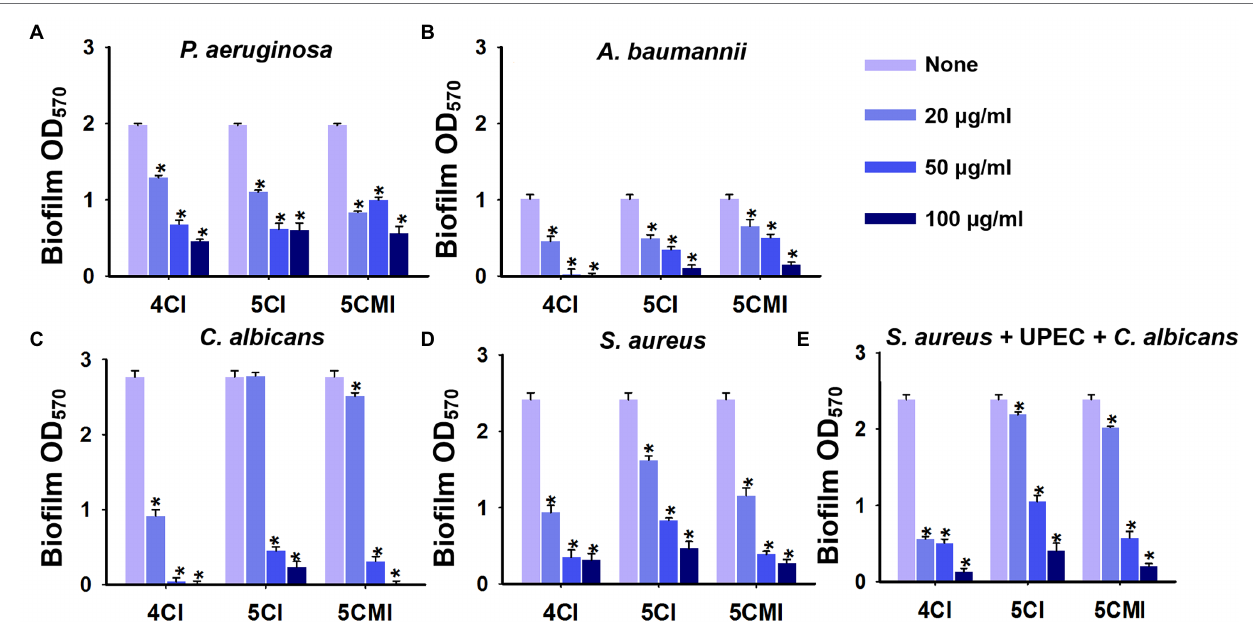
FIGURE 8 | Crystal violet quantification of biofilm inhibition by the three chloroindoles of (A) Pseudomonas aeruginosa PAO1, (B) Acinetobacter baumannii ATCC 17978, (C) Candida albicans DAY 185, (D) Staphylococcus aureus ATCC 6538, and (E) a polymicrobial biofilm ( S. aureus ATCC 6538, C. albicans DAY 185 and UPEC) grown in media comprised of equal parts of Luria-Bertani (LB), nutrient broth (NB), and potato dextrose broth (PDB) broth. Chloroindoles concentrations used are 0, 20, 50, and 100 μ g/ml. The incubation time for all the conditions is 24 h at 37 ° C. * p < 0.05 vs. non-treated